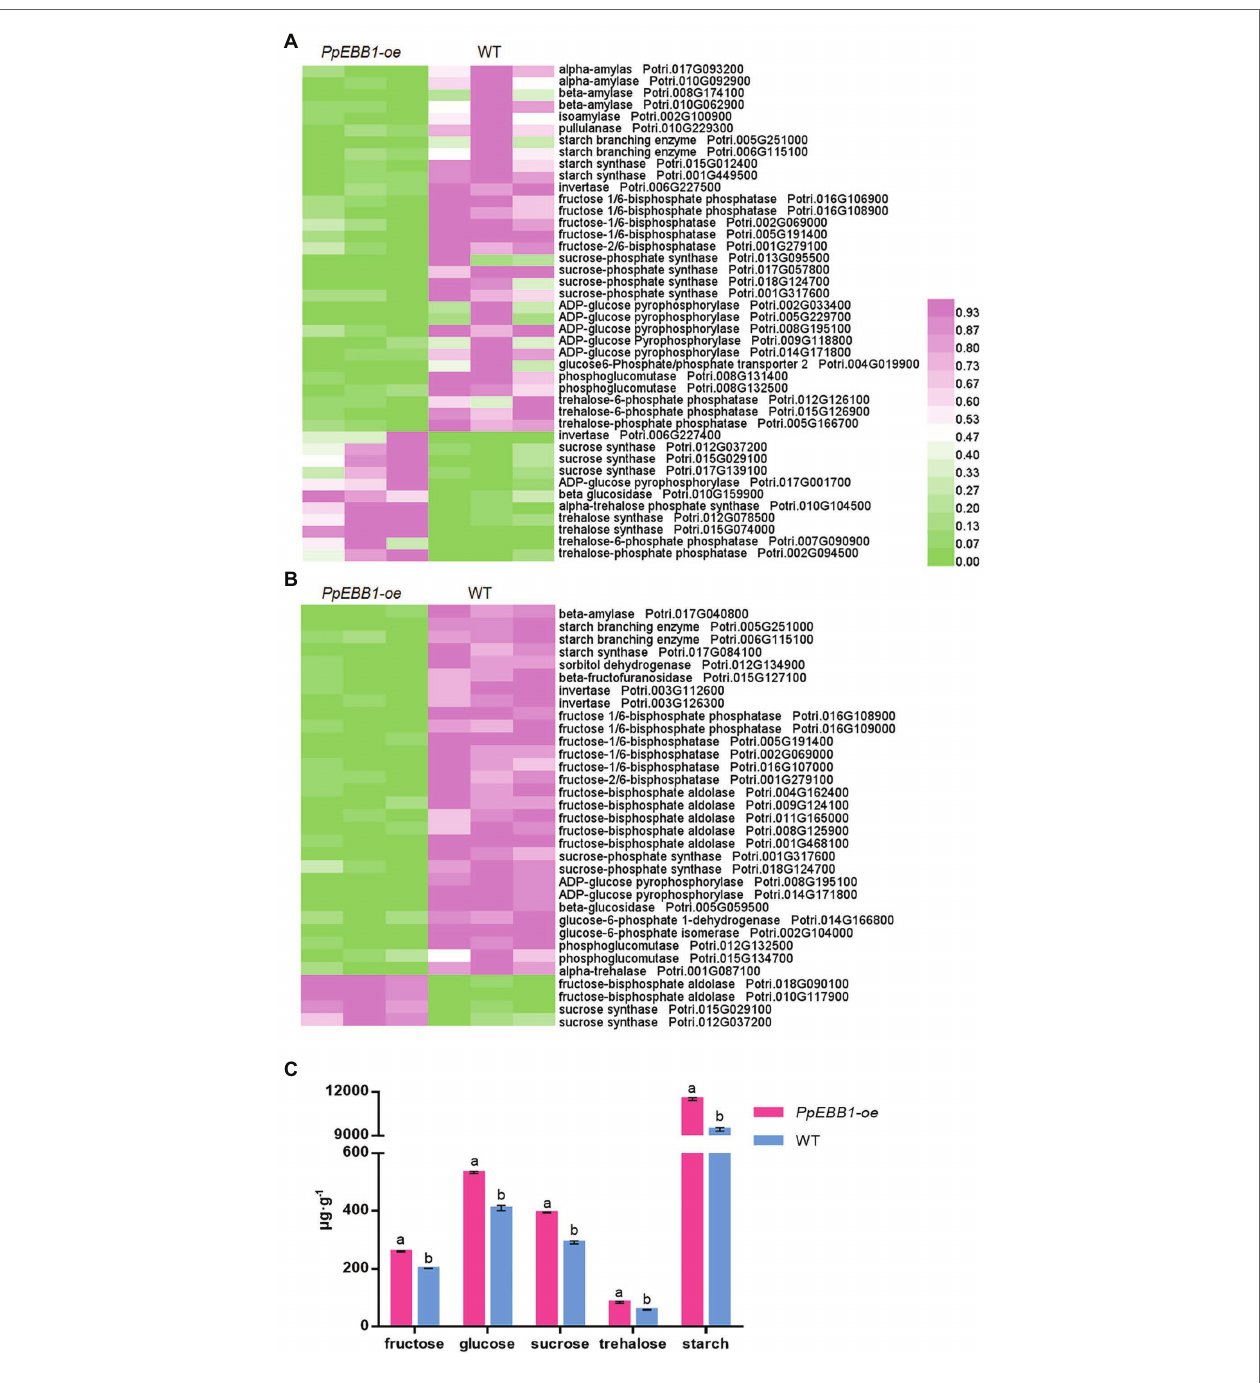
FIGURE 2 | PpEBB1 greatly influenced sugar metabolism. (A) Differentially expressed genes (DEGs) involved in sugar metabolism between PpEBB1-oe and wild type (WT). Genes with significant |log2_ratio| ≥ 1 changes between PpEBB1-oe line 29 and WT were identified as DEGs. Purple represents higher expression, while green represents lower expression. (B) Differentially expressed proteins (DEPs) involved in sugar metabolism between PpEBB1-oe and WT. Proteins with significant ( p < 0.05) > 1.3 or <1/1.3-fold changes between PpEBB1-oe line 29 and WT were identified as DEPs. Purple represents higher expression, while green represents lower expression. The expression value of DEGs and DEPs in transcriptomic and proteomics data were processed by Min-MaxNormalization from 0 to 1, and the scale is represented as the expression level. (C) Contents of different types of sugars in PpEBB1-oe and WT. The values represent the means ± SDs of three replicates. Letters indicate significant differences by ANOVA followed by Duncan’s test ( p <